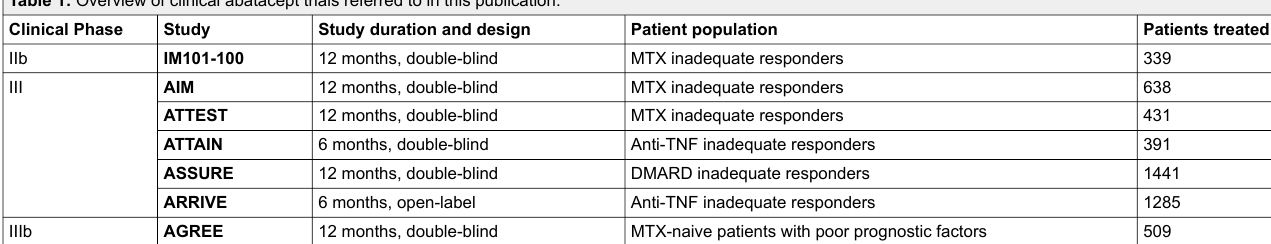
Table 1: Overview of clinical abatacept trials referred to in this publication. Clinical